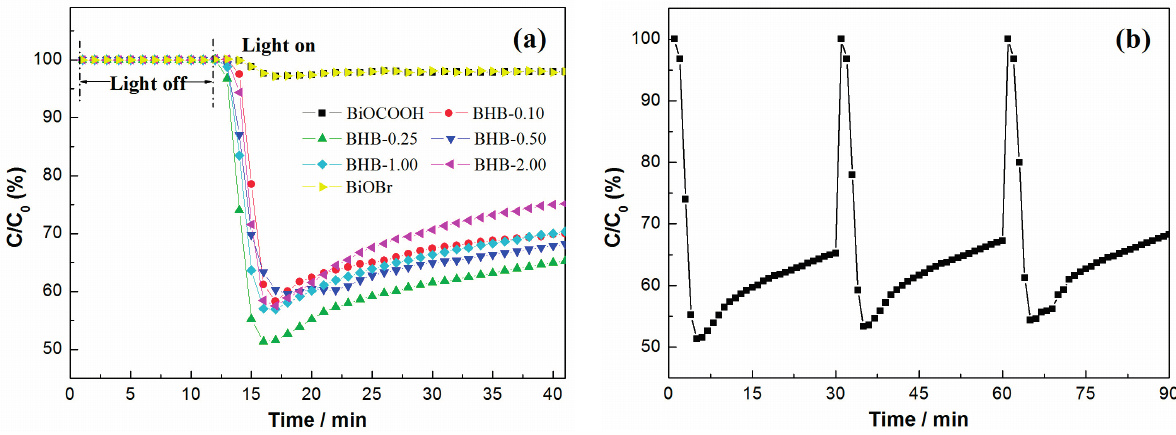
Figure 9. Visible light photocatalytic activity of pure BiOCOOH, BiOBr and BHB with different Br contents ( a ) and repeated visible light photocatalytic runs of BHB-0.25 ( b )